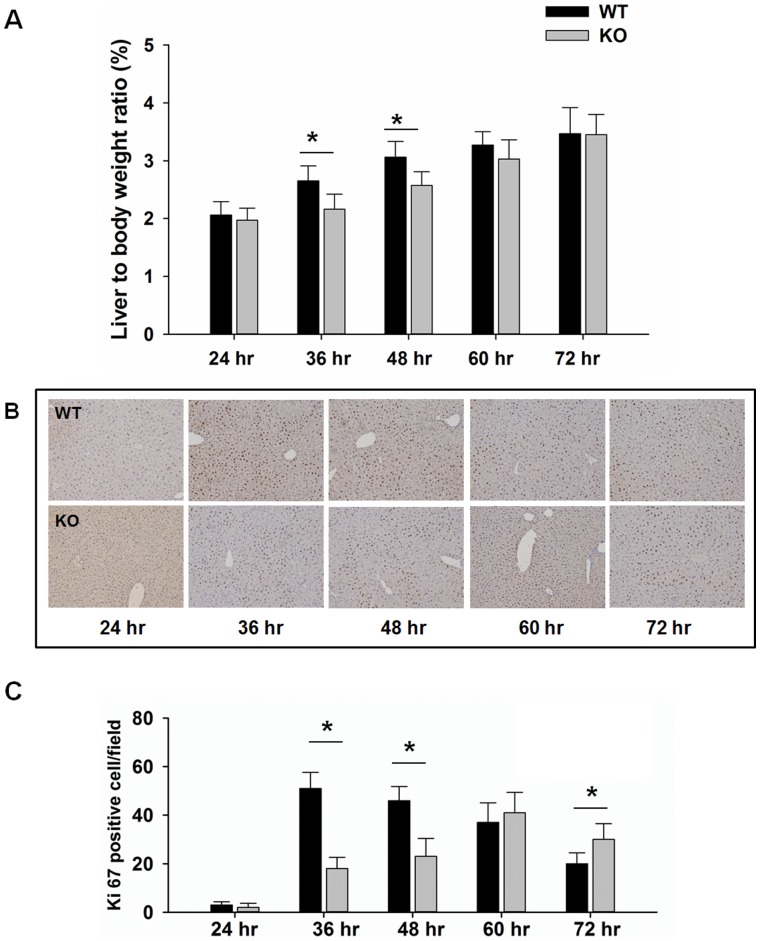
Delayed liver regeneration in PPARβ-null (KO) mice.(A) Liver-to-body weight ratios in wild-type (WT) and KO mice after PH. (B) Representative photomicrographs of Ki-67 immunohistochemical staining of liver sections from WT and KO mice at 24, 36, 48, 60, and 72 hours after PH (n = 3). (C) Ki-67 positive cells in the livers of WT and KO mice over a time course after PH. The number of proliferating hepatocytes was determined by counting the Ki-67 positive hepatocytes in at least 15 low-magnification (20 X) microscope fields for each sample. Liver sections from all mice were used for analyses. Means ± SD are graphed. * p<0.05.